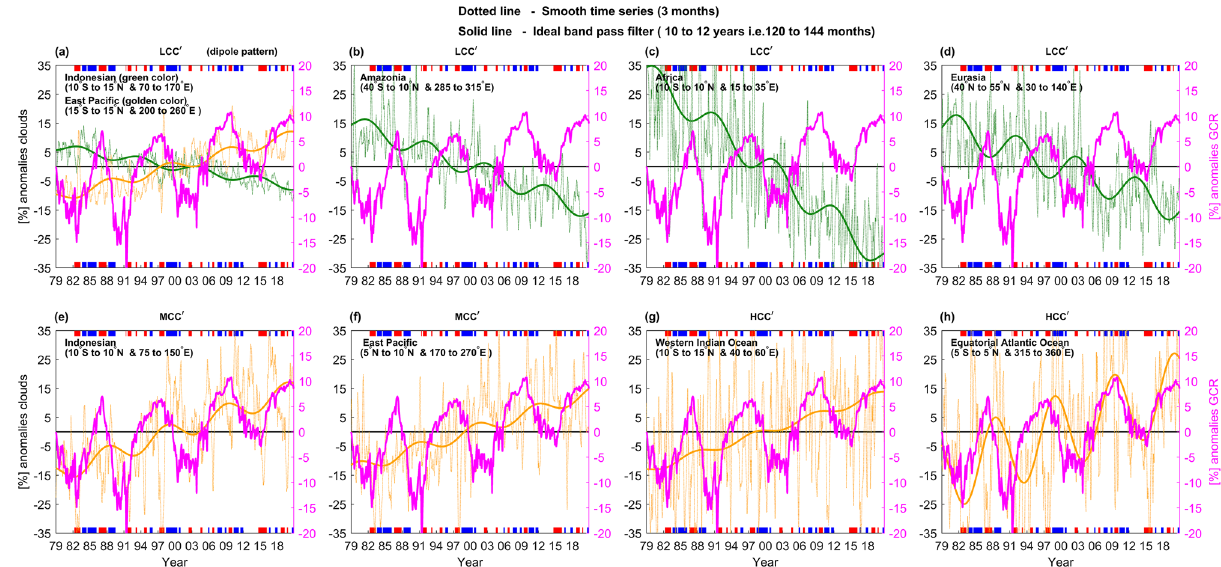
Figure 3. Time variation of cloud cover anomalies for selected regions shown in Fig. 2. In all figures the dotted line represents three month-averaged cloud cover anomalies, while the solid line represents ideal band-pass filtered data, allowing the signal between 10 and 12 years (120–140 months) in the monthly mean data. The golden (green) of dotted lines represent areas which show significant positive (negative) anomalies ′ in the composite difference analysis. ( a ) LCC anomalies for the Indonesian and East Pacific sector dipole ′ ′ pattern (Fig. 2a). ( b – d ) LCC anomalies for the Amazonia, African, Eurasia regions (Fig. 2a). ( e ) and ( f ) MCC ′ anomalies for the Indonesian and East Pacific sectors. ( g ) and ( h ) HCC anomalies for the Western equatorial Indian Ocean and equatorial Atlantic Ocean. The strips at the base and top with red and blue colors indicate El Niño and La Niña periods, respectively.